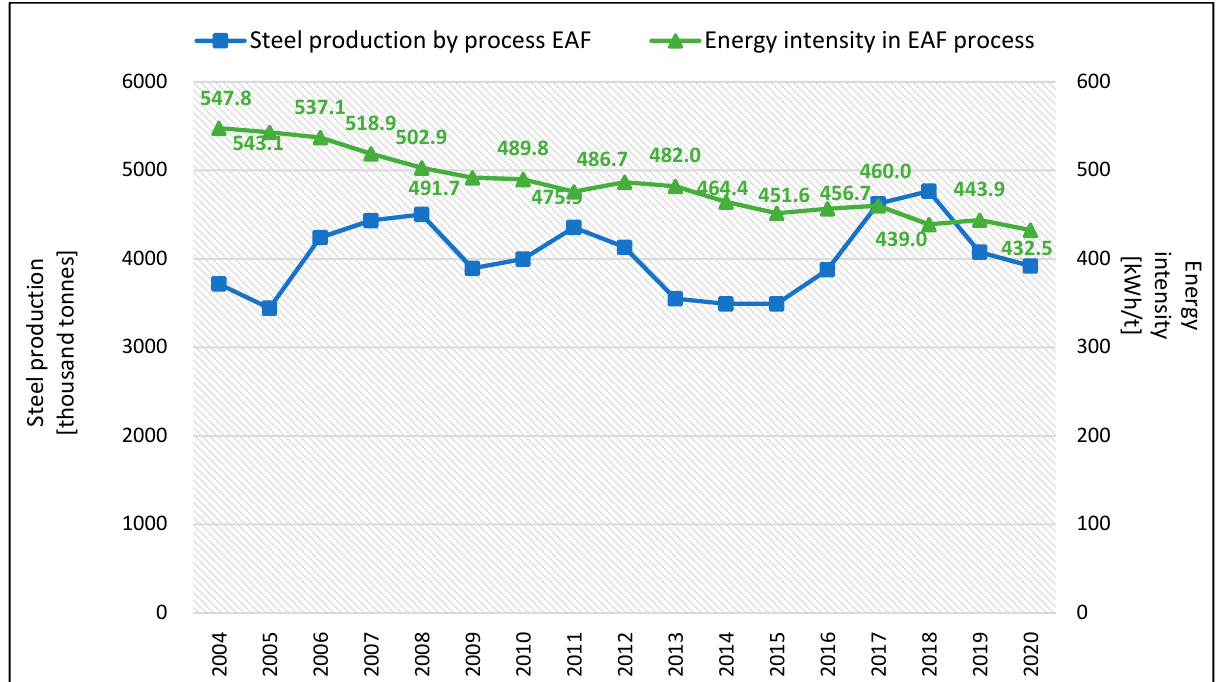
Figure 8. Energy intensity per 1 tonne of steel in the EAF process in Poland from 2004 to 2020. Source: Own elaboration based on data from [11].